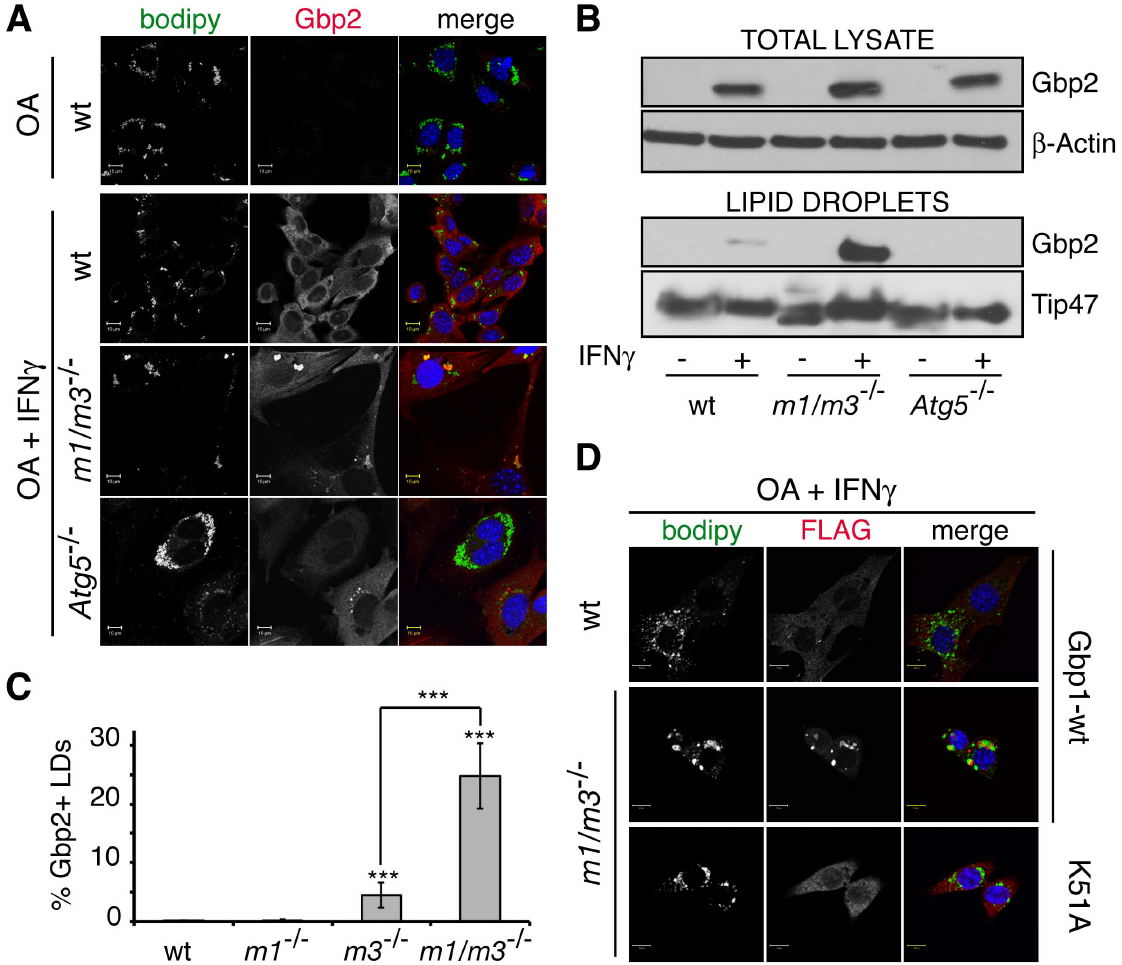
Figure 7. GBP proteins are enriched on IRGM-deficient LDs. MEFs of the indicated genotypes were treated overnight with OA alone or with OA and IFN c . ( A ) MEFs were stained for endogenous Gbp2 and LDs using BODIPY ( B ) LDs and total cell lysate were obtained from wildtype, Irgm1/ m3 2 / 2 and Atg5 2 / 2 MEFs and analyzed by immunoblotting. Here, the same lysates and LD preparations were used as in Figure 5E. The data are representative of three independent LD preparation experiments. ( C ) Quantitative analyses of Gbp2 co-localization with LDs were done using MBF- ImageJ software as described in Materials and Methods. Data are representative of three independent experiments. Statistical significance of group values relative to wildtype and between marked groups is shown (***, p , 0.005). Corresponding representative images are shown in Figure S8. ( D ) FLAG-tagged Gbp1 WT and Gbp1 K51A mutant were expressed in MEFs treated overnight with OA and IFN c . BODIPY and anti-FLAG staining was used to monitor localization of Gbp1 to